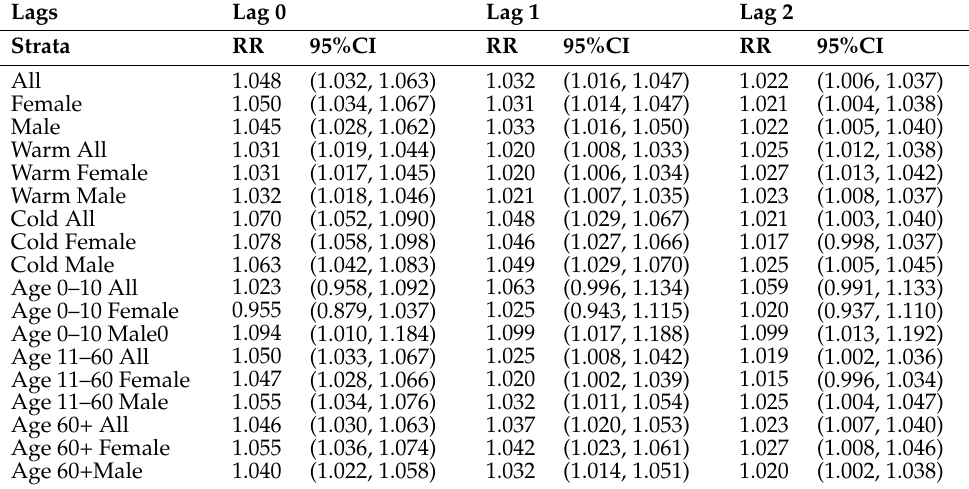
Table 2. Relative risks (RR) and their 95% confidence intervals (95%CI) for an increase in the AQHI-X level by a one interquartile range (IQR = 1.5). ICD-10 codes: C00–D48; Chapter II Neoplasms Data recorded in Toronto, Canada for the period between April 2004 and December 2015. Lags Lag 0 Lag 1 Lag 2 Strata RR 95%CI RR 95%CI RR 95%CI All 1.048 (1.032, 1.063)